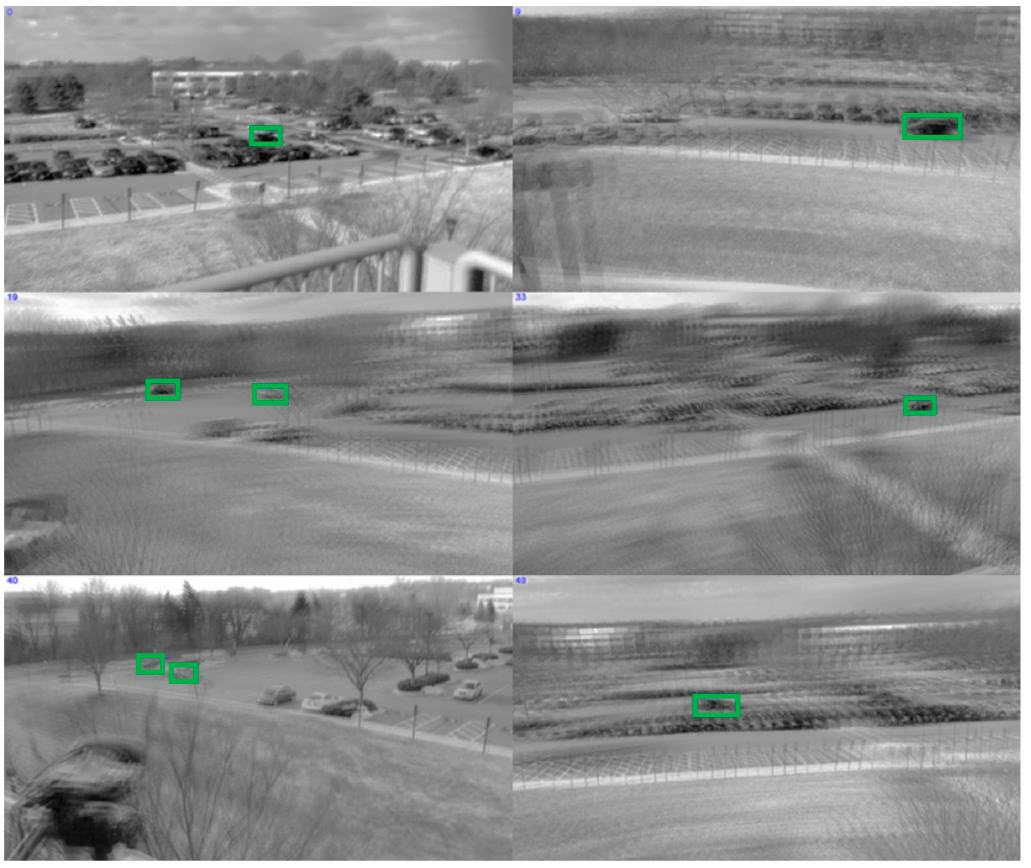
Figure 10. Fire escape video IMG428 with 0 missing pixels. Detected bounding boxes are in green and frame numbers are in the top right corner of the frame.